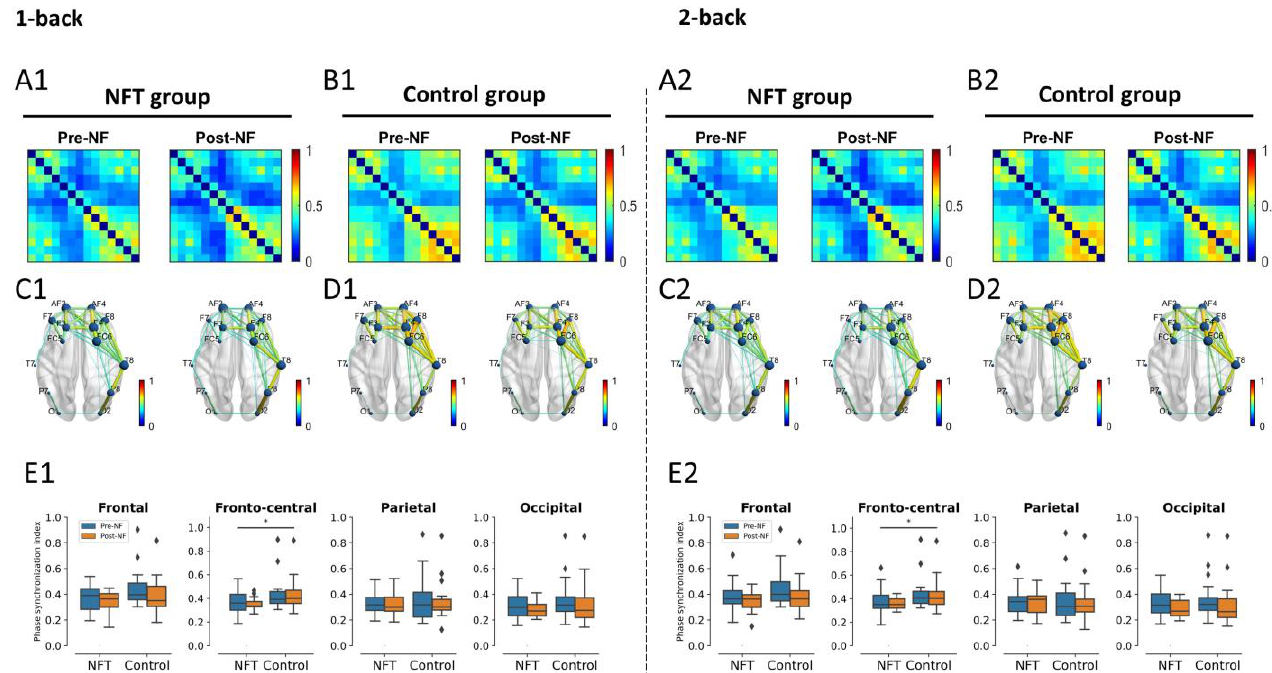
Figure 11. Beta band functional connectivity (* p < 0.05). Connectivity matrices shown in ( A1 ) for NFT group and ( B1 ) for control group and brain connections in ( C1 ) for NFT group and ( D1 ) for control group in 1-back condition. Similarly, connectivity matrices shown in ( A2 ) for NFT group and ( B2 ) for control group and brain connections in ( C2 ) for NFT group and ( D2 ) for control group in 2-back condition. The box plots in ( E1 ) and ( E2 ) show the phase synchronization index in different brain lobes in 1-back and 2-back conditions, respectively. The coloured bars of the connectivity matrices and brain connections represent the strength of synchronization between the EEG channels. It ranges from 0 (no synchronization) to 1 (full synchronization). The diamond shape in the box plots represents the outliers in the data.